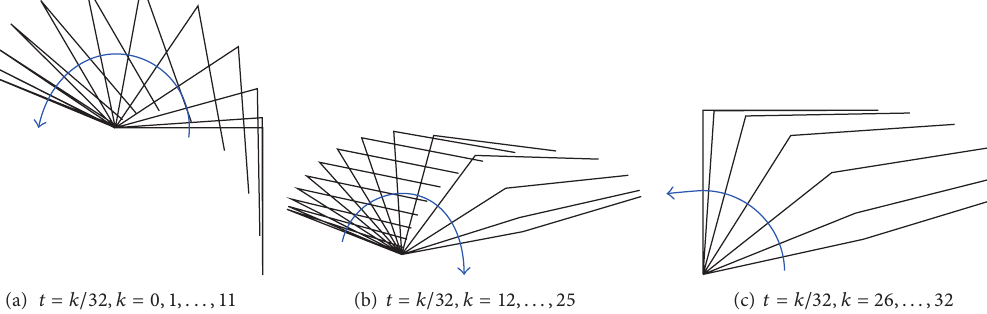
Figure 2: Sequence of configurations of the robot manipulator at times 𝑘(1/32) with 𝑘 = 0, 1, .. ., 32 corresponding to the optimal solution of problem 1, a boundary value problem for the planar 𝑅𝑅 robot manipulator with boundary conditions 𝜃 1 (𝑡 𝐼 ) = 0[ rad ] , 𝜃 2 (𝑡 𝐼 ) = −𝜋/2 [rad], ̇𝜃 (𝑡 ) = 0[ rad / s ] , ̇𝜃 (𝑡 ) = 0[ rad / s ] , 𝜃 (𝑡 ) = 𝜋/2 [ rad ] , 𝜃 (𝑡 ) = −𝜋/2 [ rad ] , ̇𝜃 (𝑡 ) = 0 [ rad / s ] , and ̇𝜃 (𝑡 ) = 0[ rad / s ] , obtained with a 1 𝐼 2 𝐼 1 𝐹 2 𝐹 1 𝐹 2 𝐹 discretization of [𝑡 𝐼 ,𝑡 𝐹 ] into 64 subintervals. The initial and final times are 𝑡 𝐼 = 0 and 𝑡 𝐹 = 1 [ s ] , respectively. The corresponding control and state variables are represented in Figure